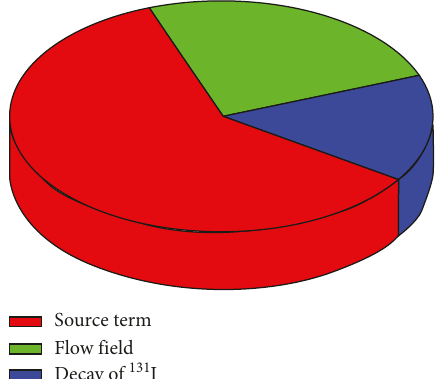
Figure 9: The mechanism of short-term radionuclide diffusion in the ocean.